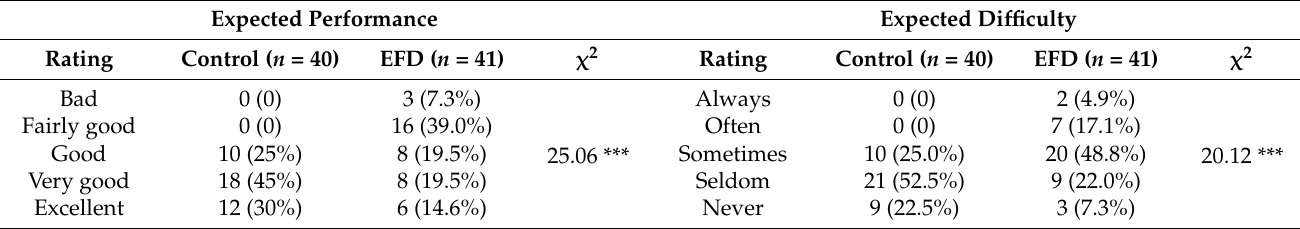
Table 2. Between-group differences in process and product.